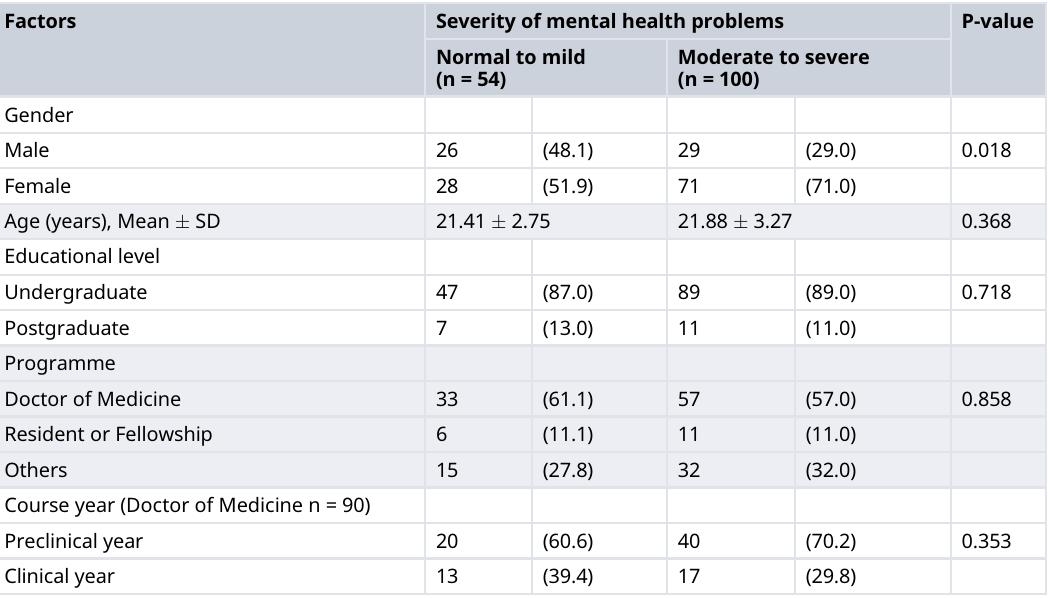
Table 4. Factors associated with mental health problems